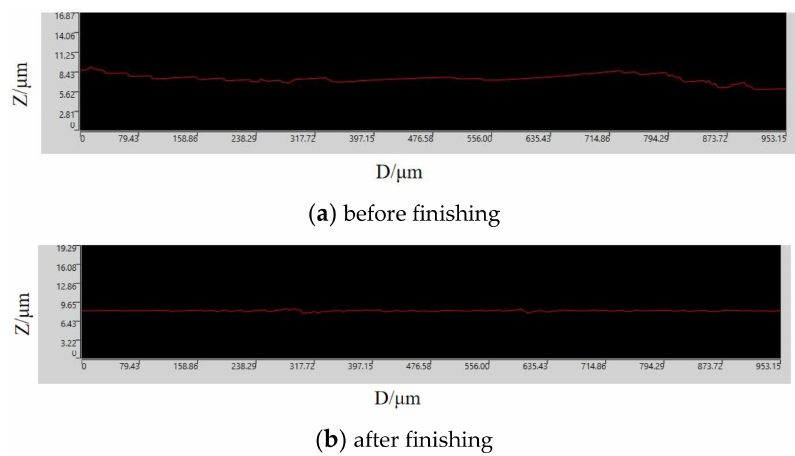
Figure 14. Surface roughness of AZ31B magnesium alloy